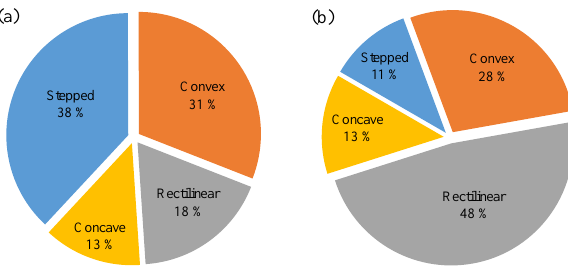
Figure 3. Statistical analysis results: (a) classification of loess slopes in Lishi City, Shanxi Province, China, on the basis of a field survey of 212 loess slopes, indicating that stepped slopes are dom- inant in the study area. (b) Percentage of cracking–sliding failures that occurred in different types of loess slopes across the study area, showing that rectilinear slopes are highly susceptible to loess fail-